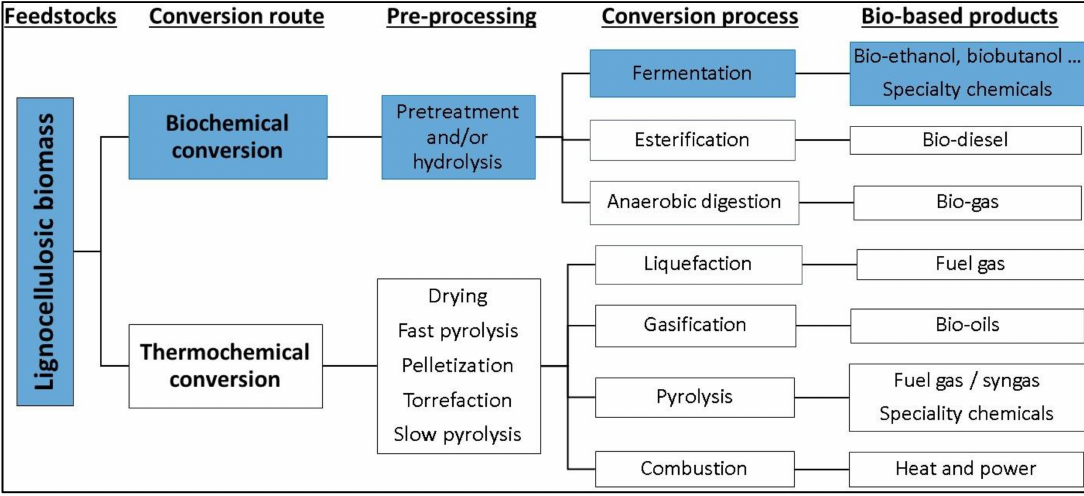
Figure 1. Conversion routes for lignocellulosic biomass feedstocks to bio-based products